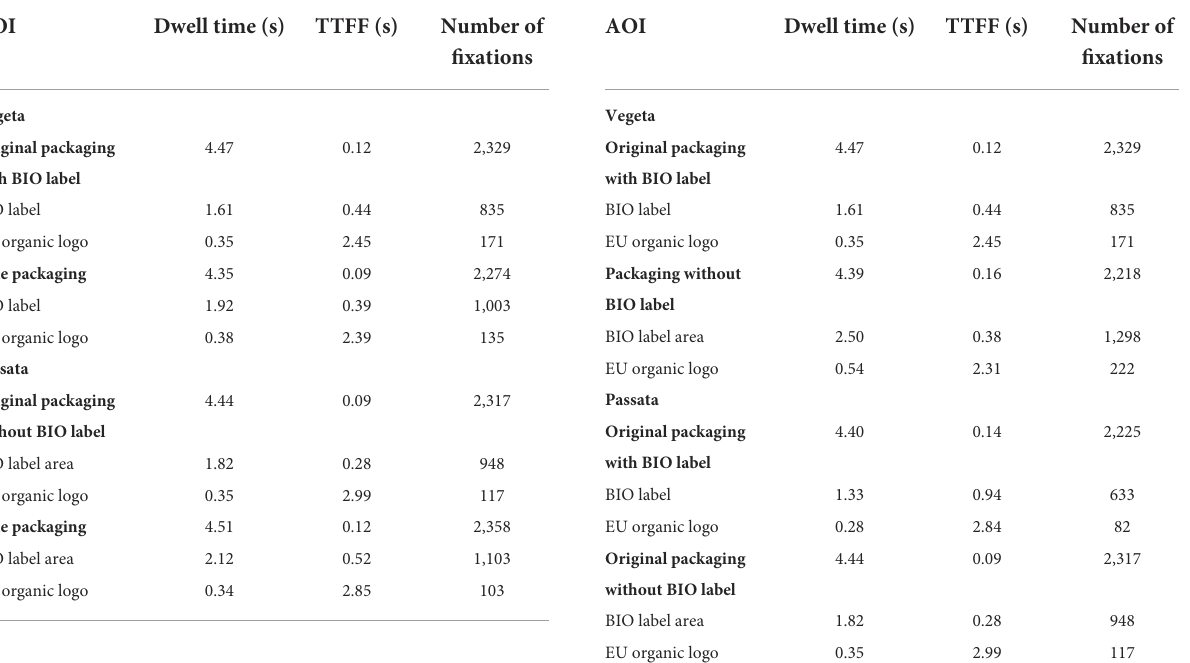
TABLE 1 Eye-tracking metrics assessing visual attention during color manipulation for both products. AOI Dwell time (s) TTFF (s) Number of